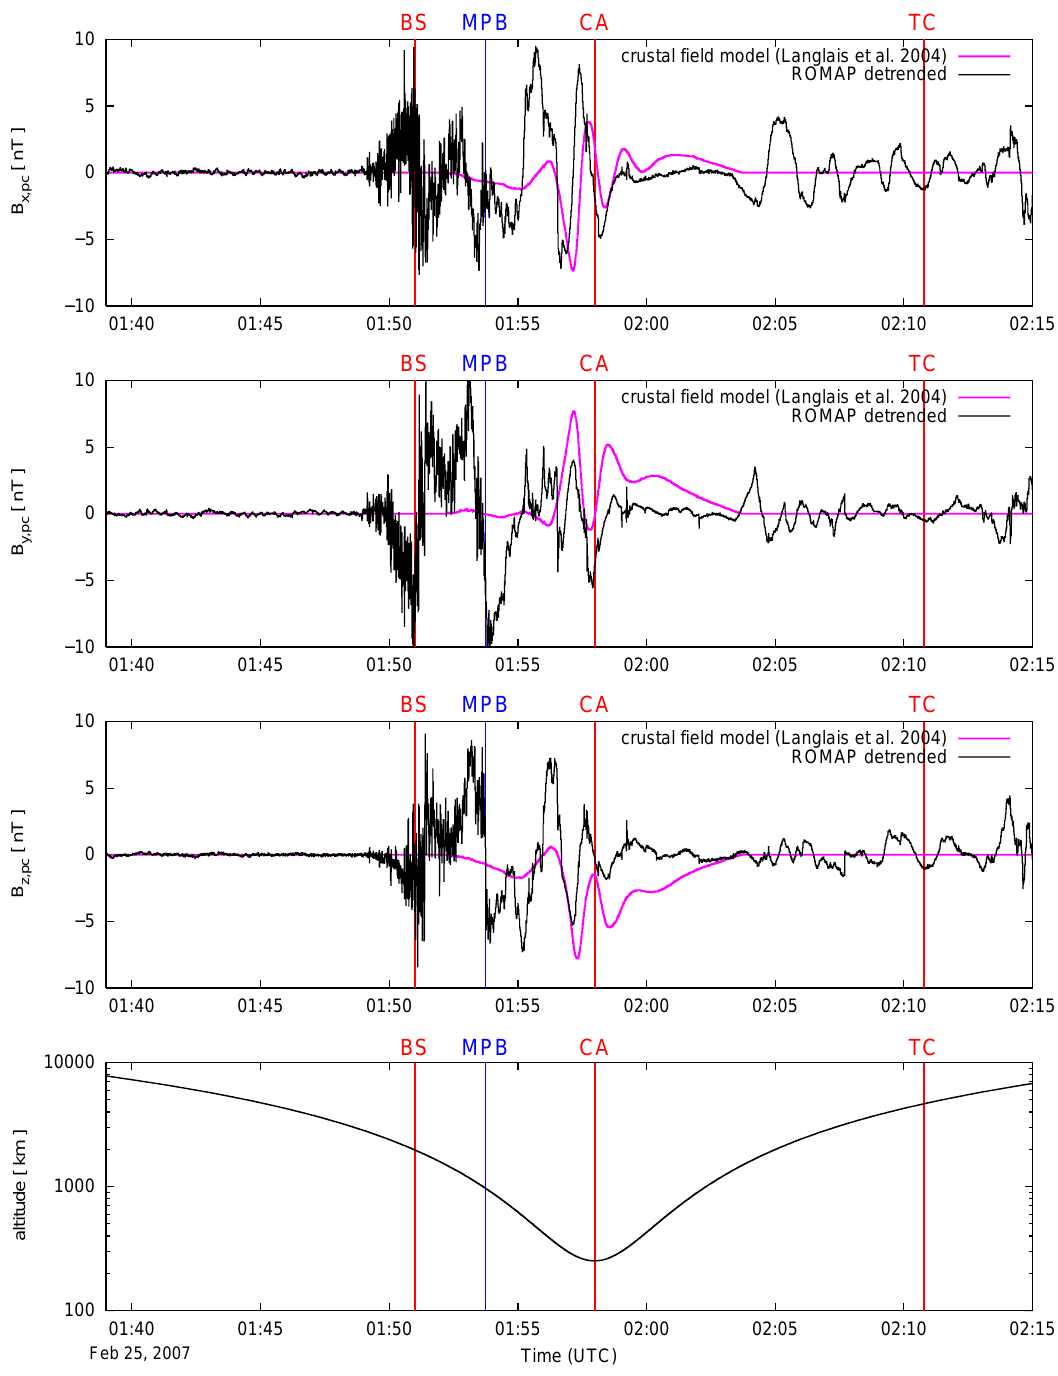
Fig. 4. Detrended ROMAP data in planetary Cartesian coordinates in comparison with the predictions by Langlais et al. (2004). All peaks in the ROMAP data can be predicted by the crustal